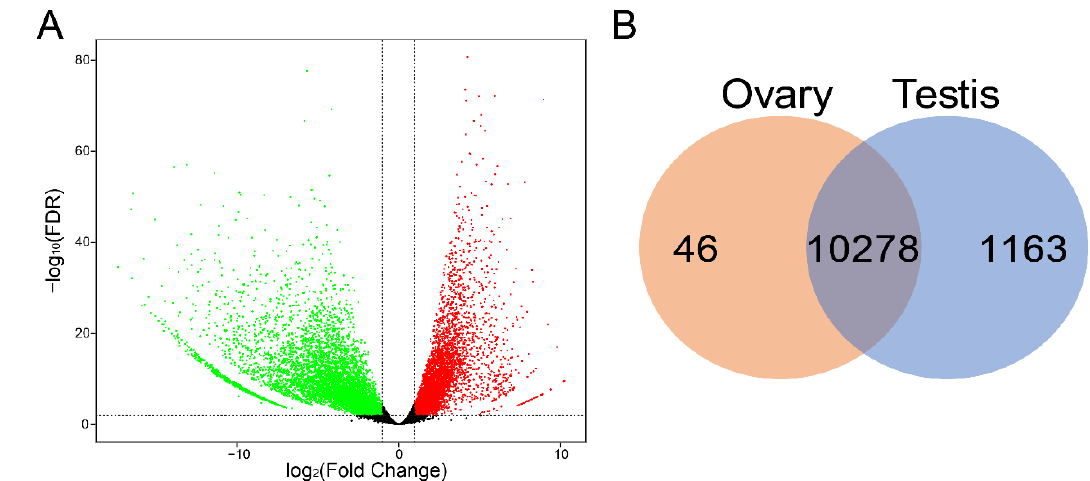
Figure 2. Differential gene expression between the ovaries and testes of D. hystrix . ( A ) Volcano plot of the differences in gene expression. Red dots: upregulated, represent ovary-biased genes; Green dots: downregulated, represent testis-biased genes. ( B ) Venn diagram showing the distribution of testis-specific and ovary-specific DEGs.